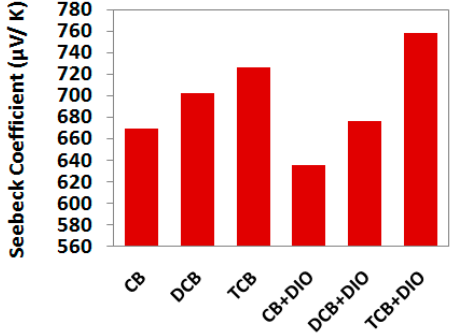
Figure 4. Seebeck coefficient values of PTB7 samples prepared from different solvents with and without DIO.